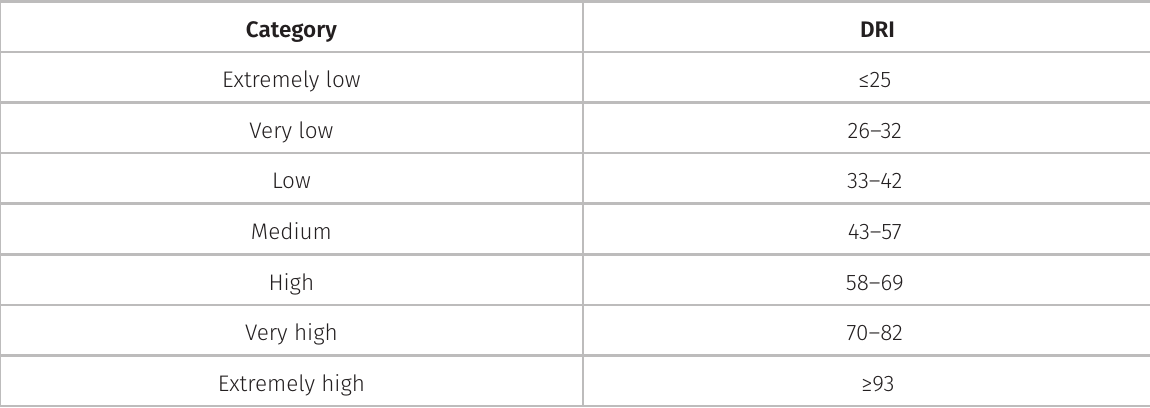
Table I. Classification categories of DRI (Dahl 2003).